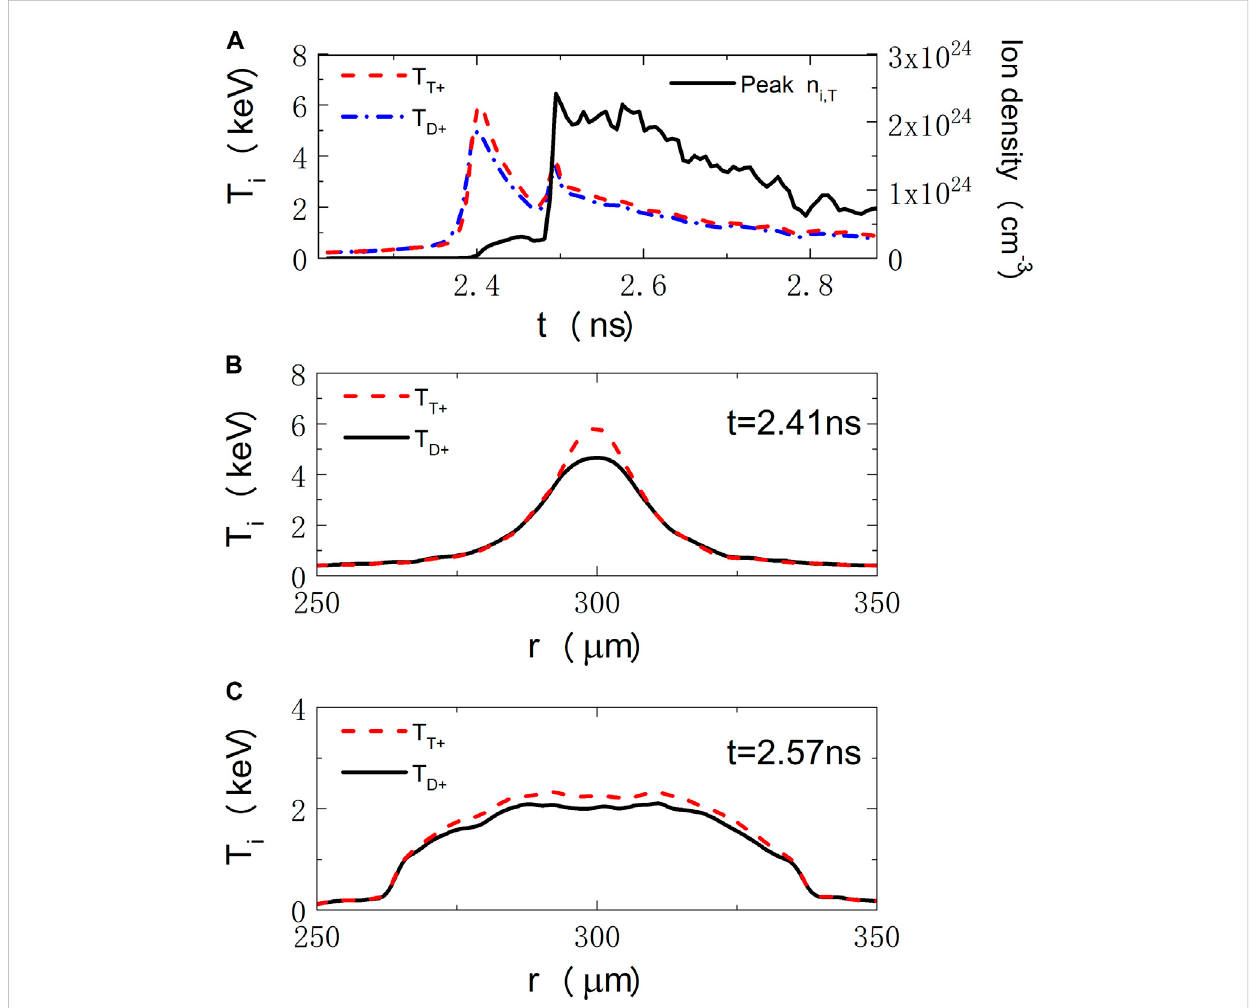
FIGURE 4 (A) Time evolution of the density and ion temperature at the target center. For comparison, we plot the D (solid black) and T (red-dashed line) temperatures at (B) t = 2.41 ns and (C) t = 2.57